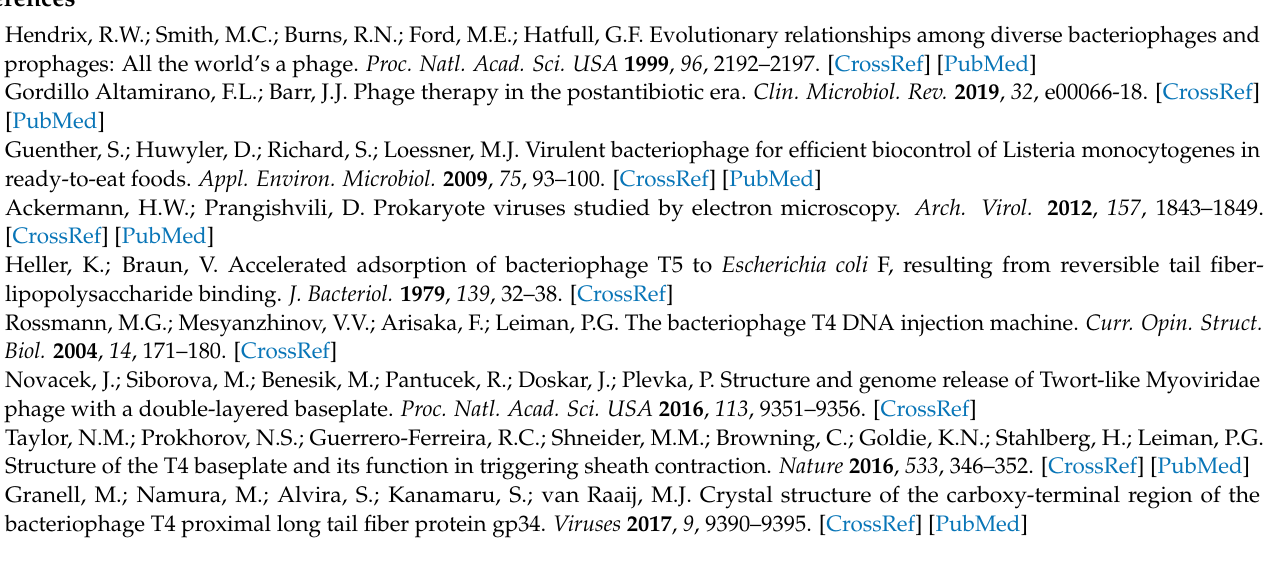
complex; Figure S3: The cryo-EM data analysis of gp24-gp25 complex. (a) A representative raw micrograph of the gp24-gp25 complex. (b) The resolution curve of the cryo-EM maps estimated using the gold-standard Fourier shell correlation at 0.143 criterion. (c) The local resolution map of the gp24-gp25 complex estimated by cryoSPARC 3.1. (d) The models and the corresponding maps for the representative segments of gp24 and gp25; Figure S4: The SDS-PAGE analysis of the purified gp24, gp25 and gp24-gp25 complex. The protein samples were treated with β -Mercaptoethanol without boiling. The lane M represents the standard protein marker, whereas the samples 1~6 are the same as in Figure 1b; Figure S5: The protein denaturation curve of the gp24 trimer. The calculated Tm value of 76.6 ◦ C is labeled; Figure S6: Cartoon representation of gp25 trimer, shown in top view. Three subunits are colored in blue, red and green, respectively; Figure S7: Structures of gp25 and the intermolecular chaperone domains from different phages. The structures are shown in cartoon and colored differently; Table S1: The mass spectrometry analysis of the intact Pam3